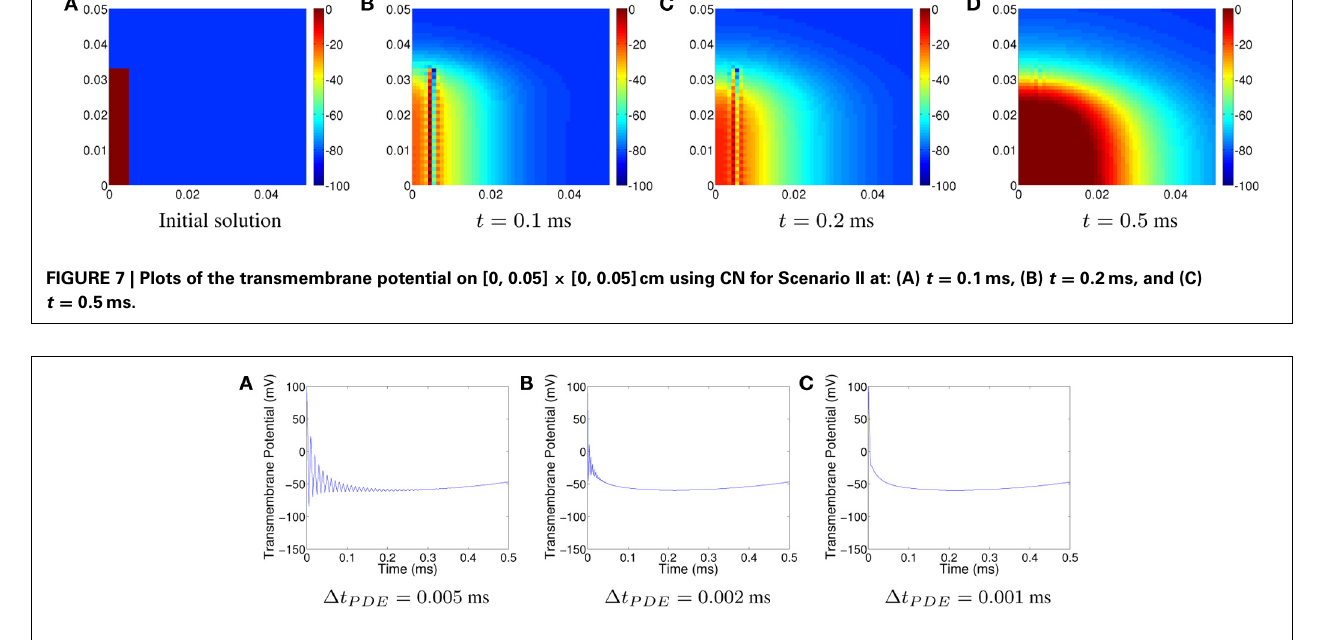
FIGURE 8 | Plots of the transmembrane potential at the spatial point (0.125, 0.125) and t ∈ [0,0.5]ms for Scenario II using CN and: (A) (cid:3) t